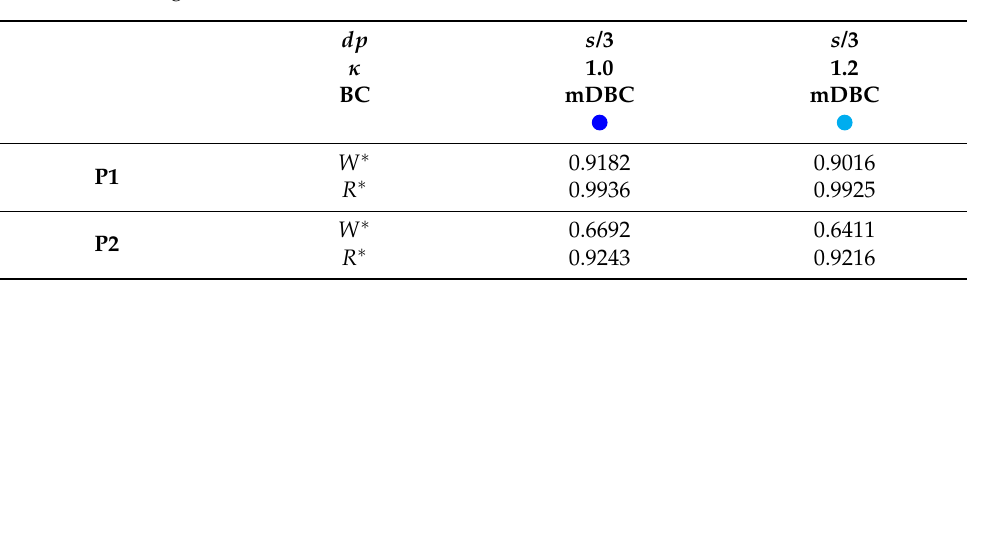
Table 1. Index of agreement and linear correlation error at P1 and P2 for two different